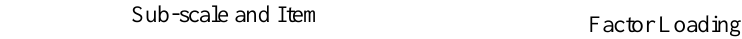
Exploratory Factor Analysis Results for Factor Loading on the Revised AEQ-T Scale (Japanese